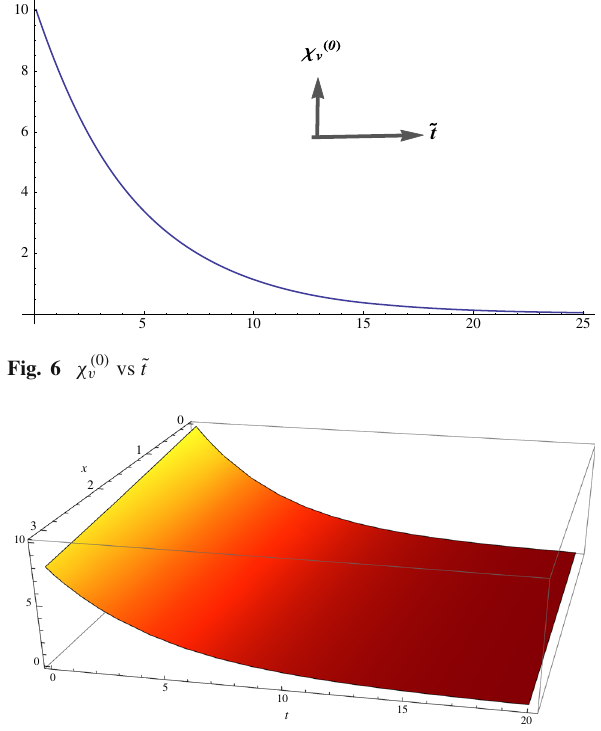
Fig. 7 χ ( 0 ) vs φ (along x axis) and t